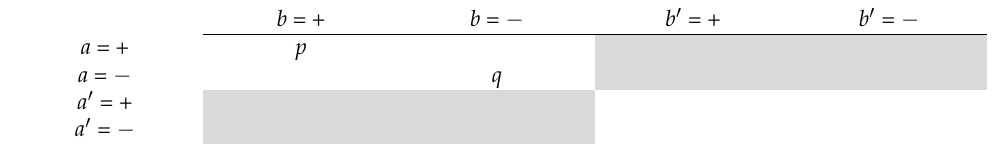
Table A3. A sequence of tables to illustrate the implications of S > 2: a , b (cid:48) and a (cid:48) , b